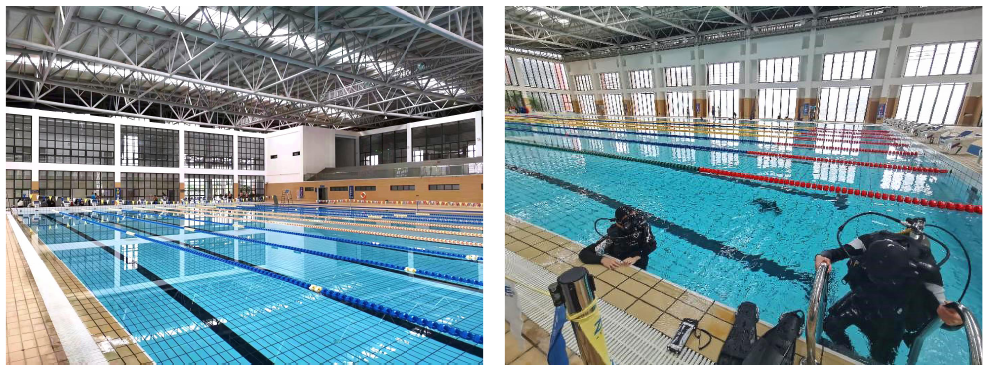
Figure 13. The outfield experimental scene.